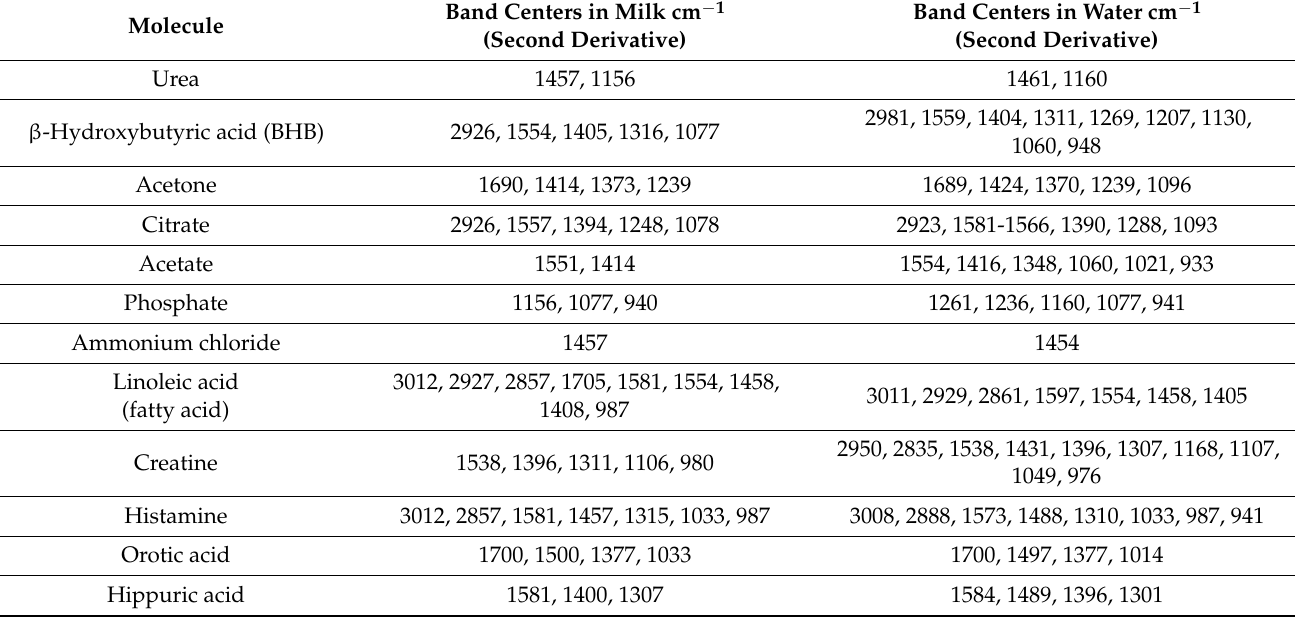
Table 1. IR band centers of minor milk components detected in the FTIR spectra of spiked milk samples and aqueous solutions of the respective